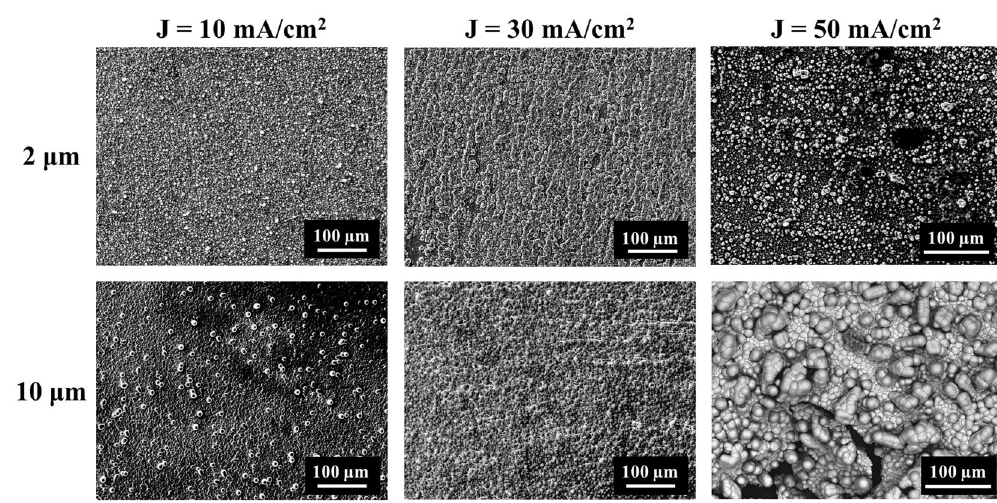
Figure 2. Electrochemical deposition of (2 and 10) μ m thick Ni films at current densities of 10 mA/cm 2 , 30 mA/ cm 2 , and 50 mA/cm 2